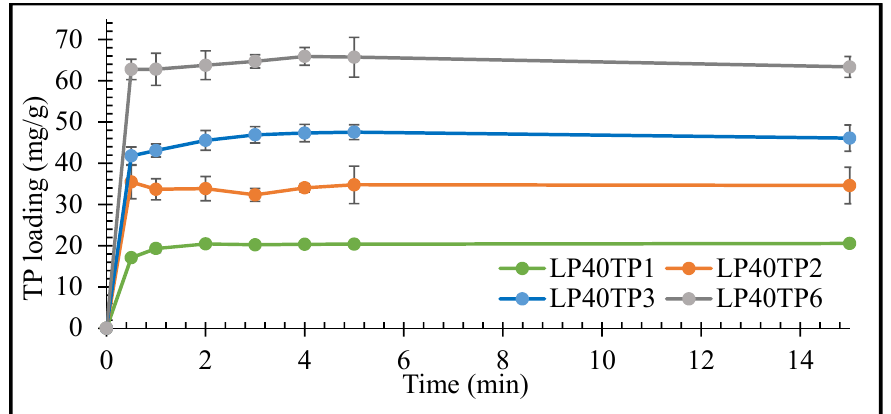
Figure 6. Uptake kinetics of TP by LP with 40 mg / mL LP. Values expressed are means with standard deviations as error bars, n =